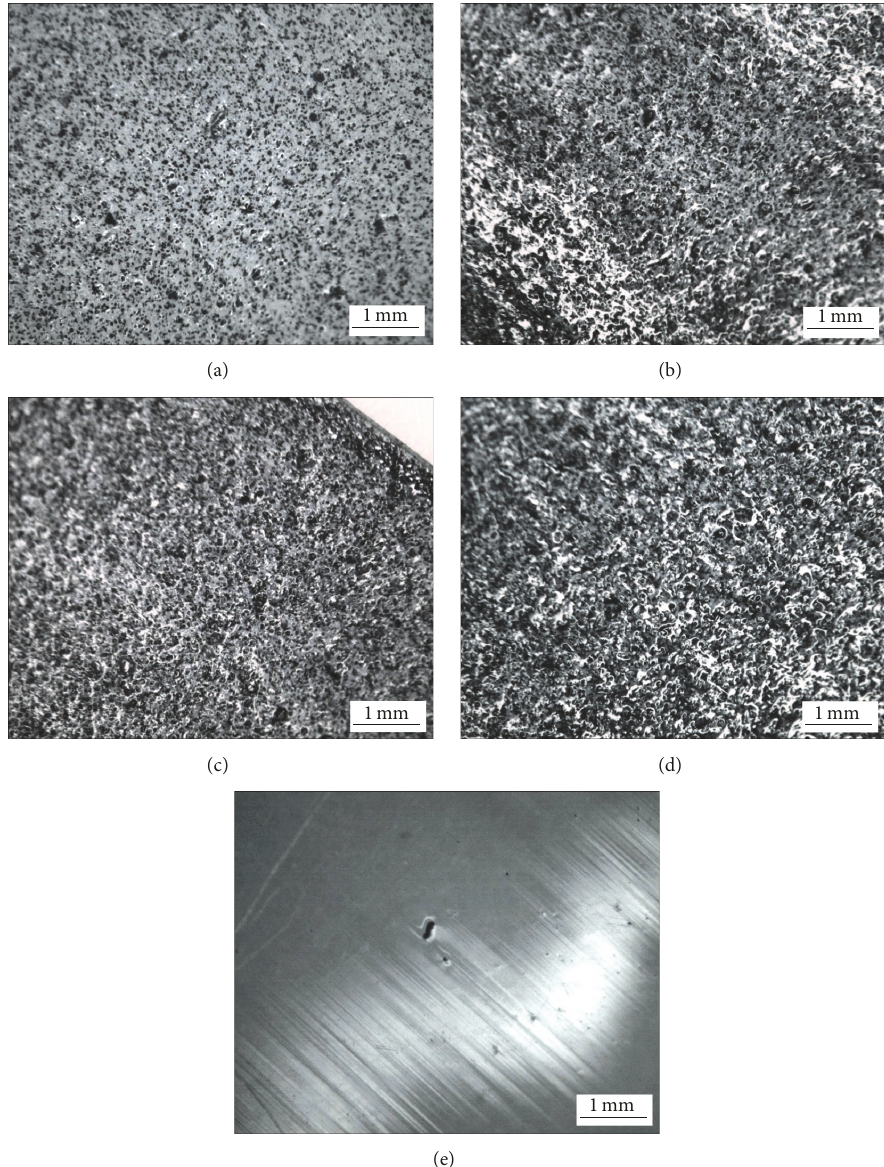
Figure 9: Morphology of PLA-PNSP biocomposite surfaces at different treatments: (a) 5% wt. PNSP defatted, (b) 7.5% wt. PNSP defatted, (c) 5% wt. PNSP untreated, (d) 7.5% wt. PNSP untreated, and (e) neat